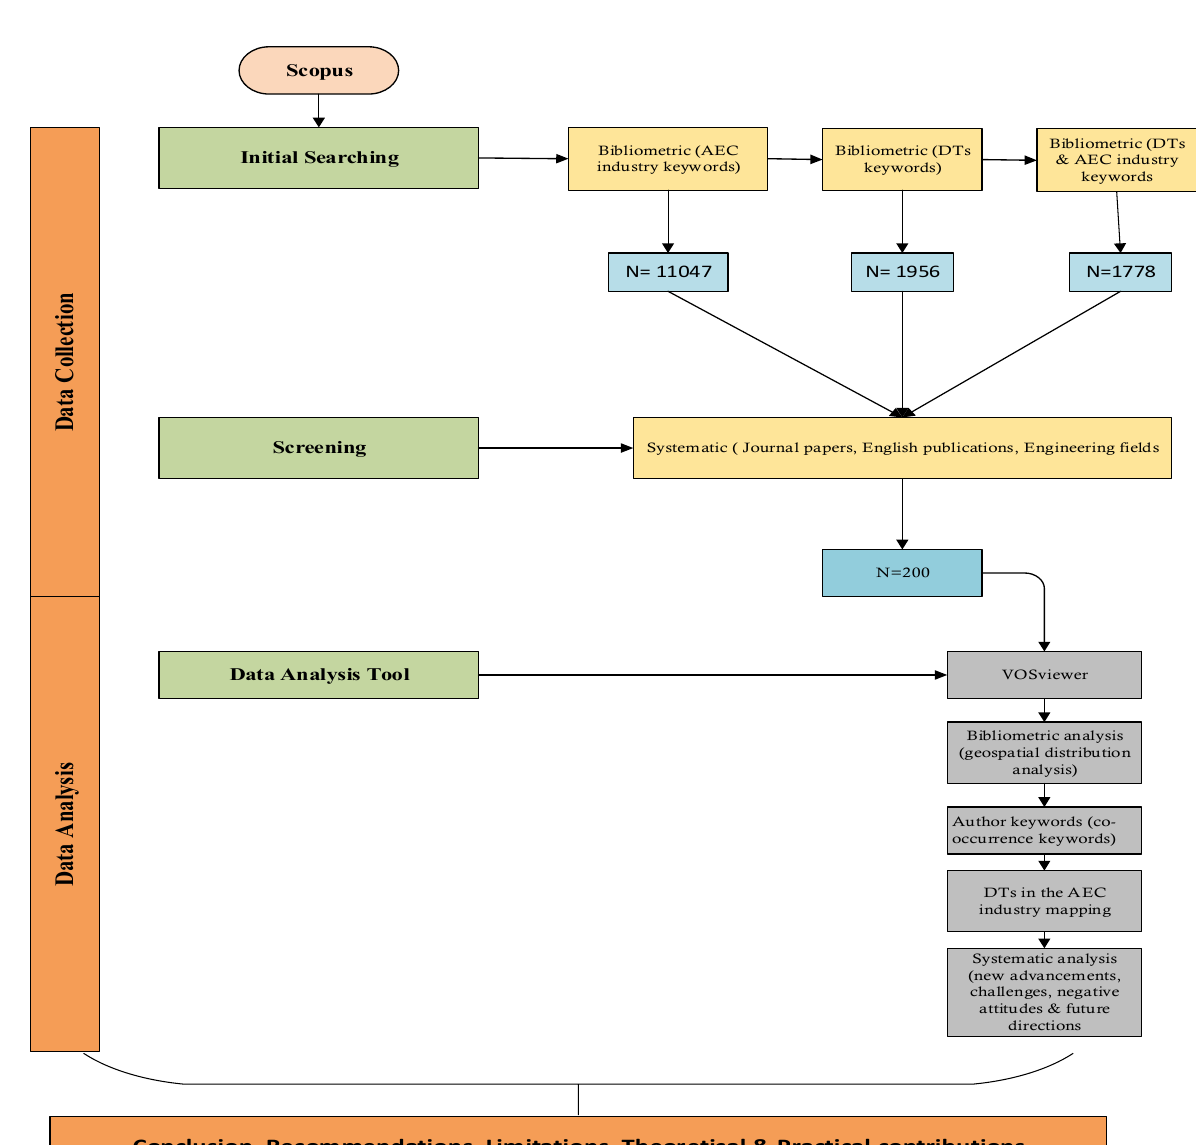
Figure 1. Research flowchart